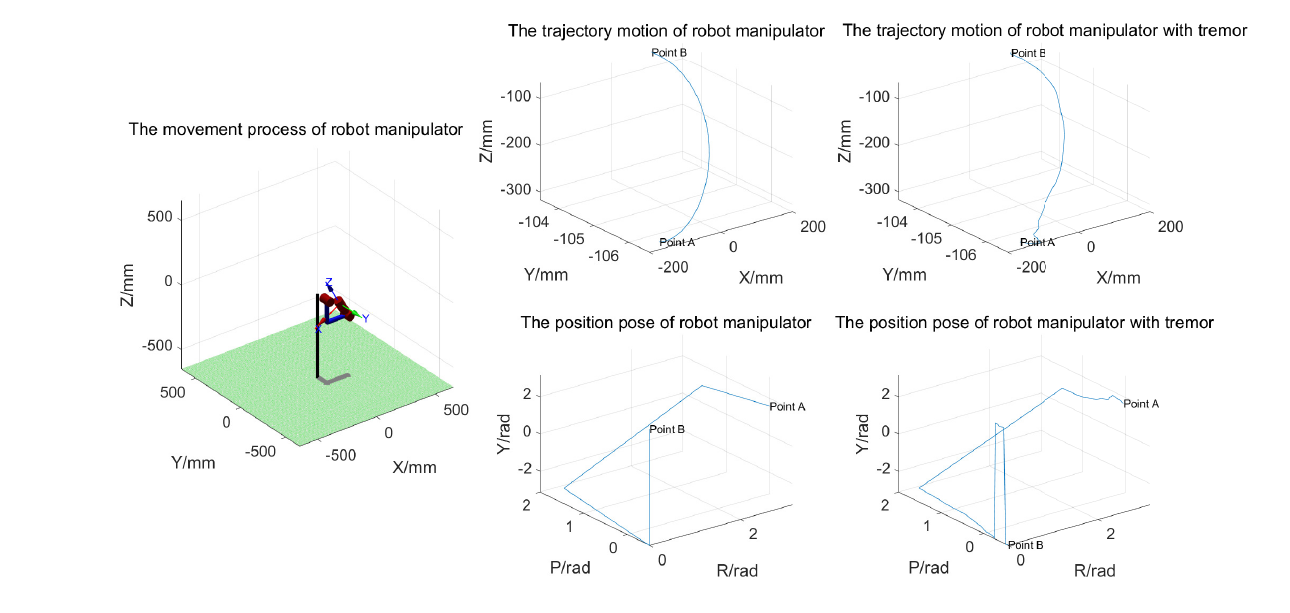
Figure 9. Simulated robot manipulator, motion and